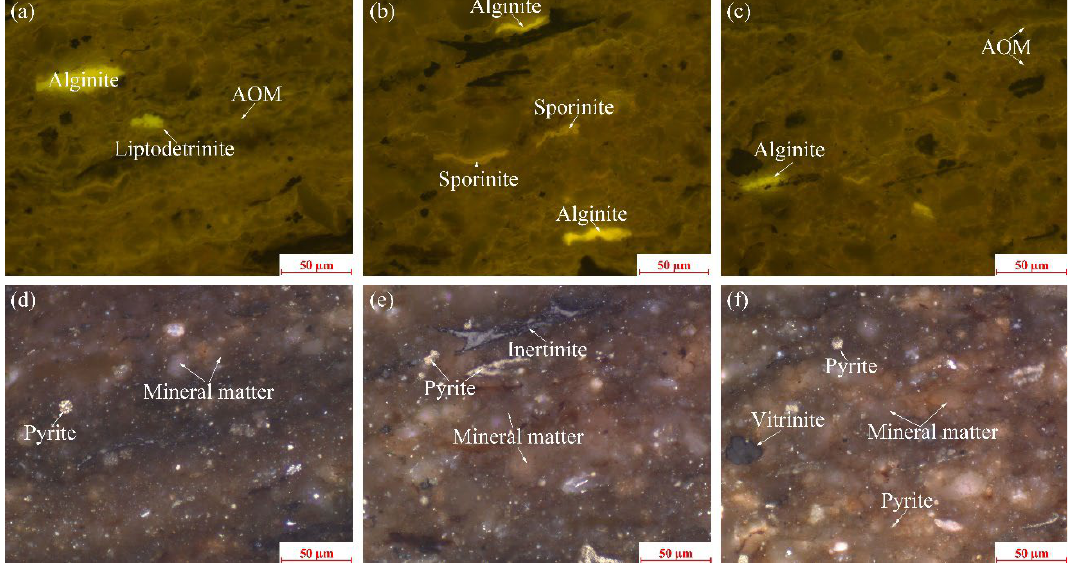
Figure 1. Illustrative examples of micrographs of macerals and minerals. ( a – c ) fluorescence mode; ( d – f ) white reflected light mode, same field as ( a – c ). AOM: Amorphous organic matter.